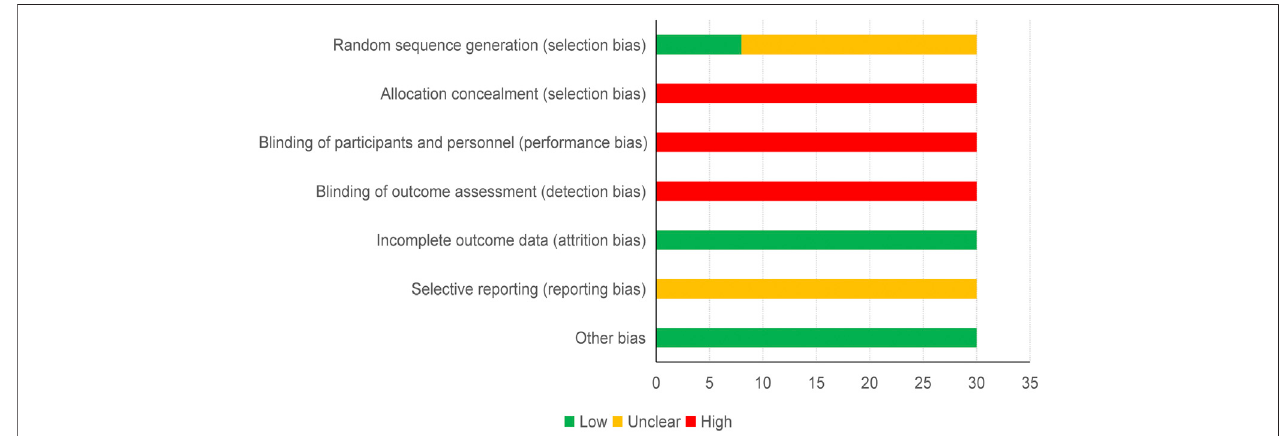
FIGURE 4 | Risk of bias graph.